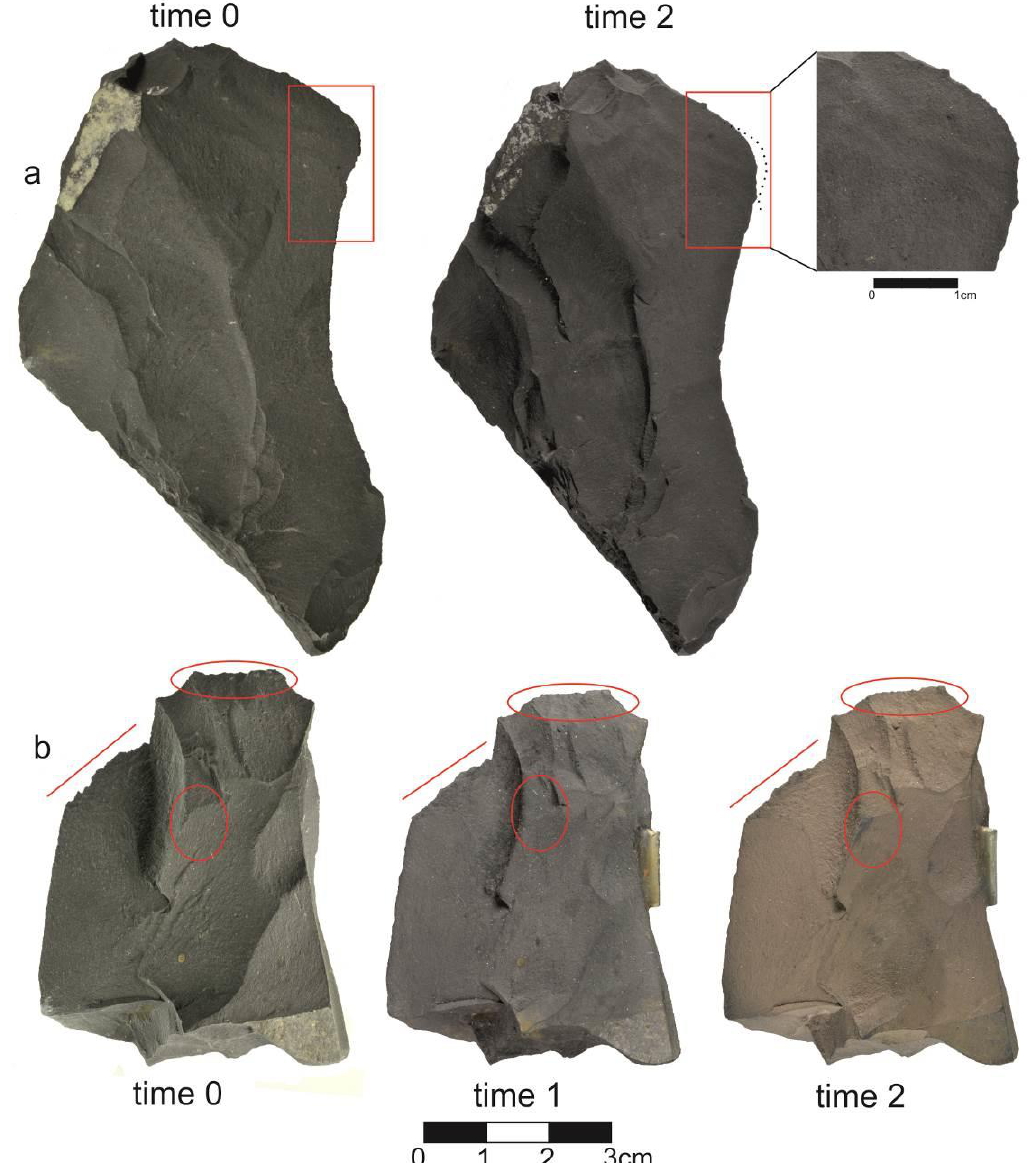
Figure 6. Pieces with macroscopically visible alterations: a) Ishbas1-MC1 (skinning) - before use (time 0) and after total of 50 minutes of use (time 2). The rectangle shows the most used and most altered portion of the edge, and the dashed line above the edge after time 2 indicates changes in the edge in comparison with time 0; b) Ishbas1(trampling and tumbling) - before PDSM experiments (time 0), after bear trampling experiment (time 1) and after tumbling experiment (time 2). The ovals and lines indicate alterations visible